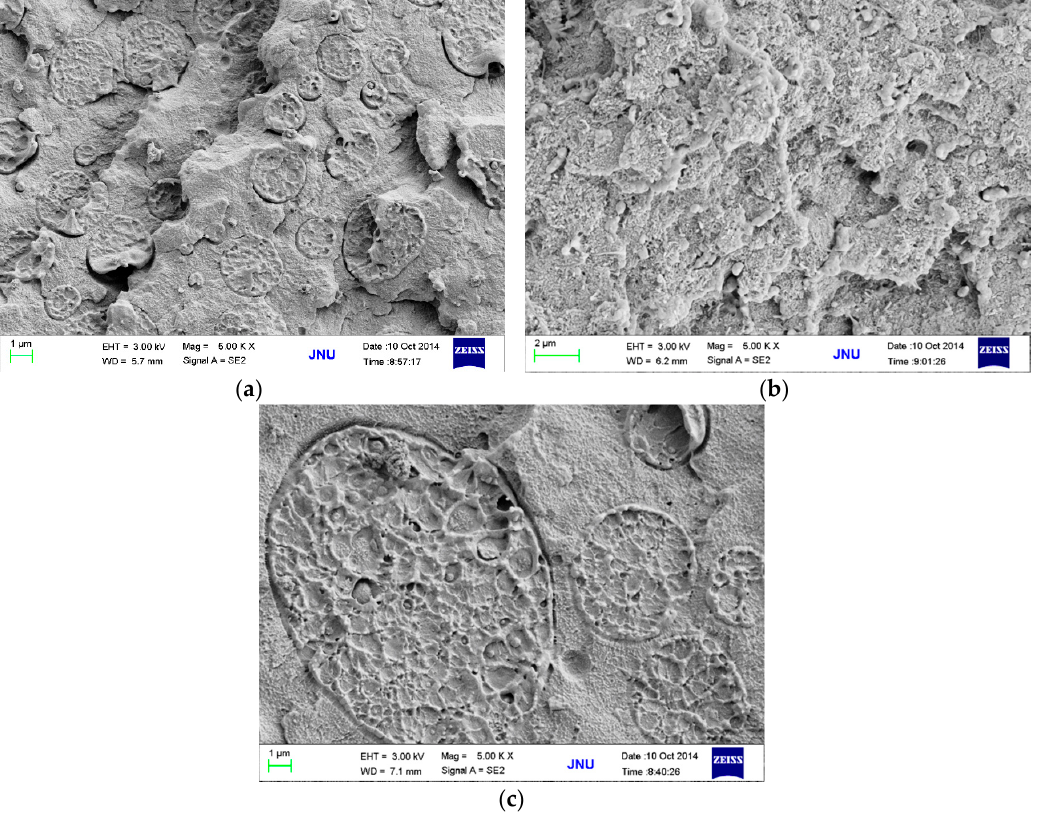
Figure 3. SEM micrographs of PPS/PEEK/MWCNT nanocomposites containing 1 wt % MWCNT